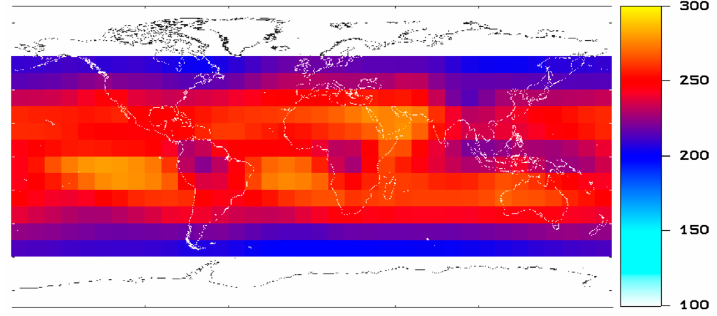
Figure 6. The 13-year mean ERBS Wide Field Of View (WFOV) Outgoing Longwave